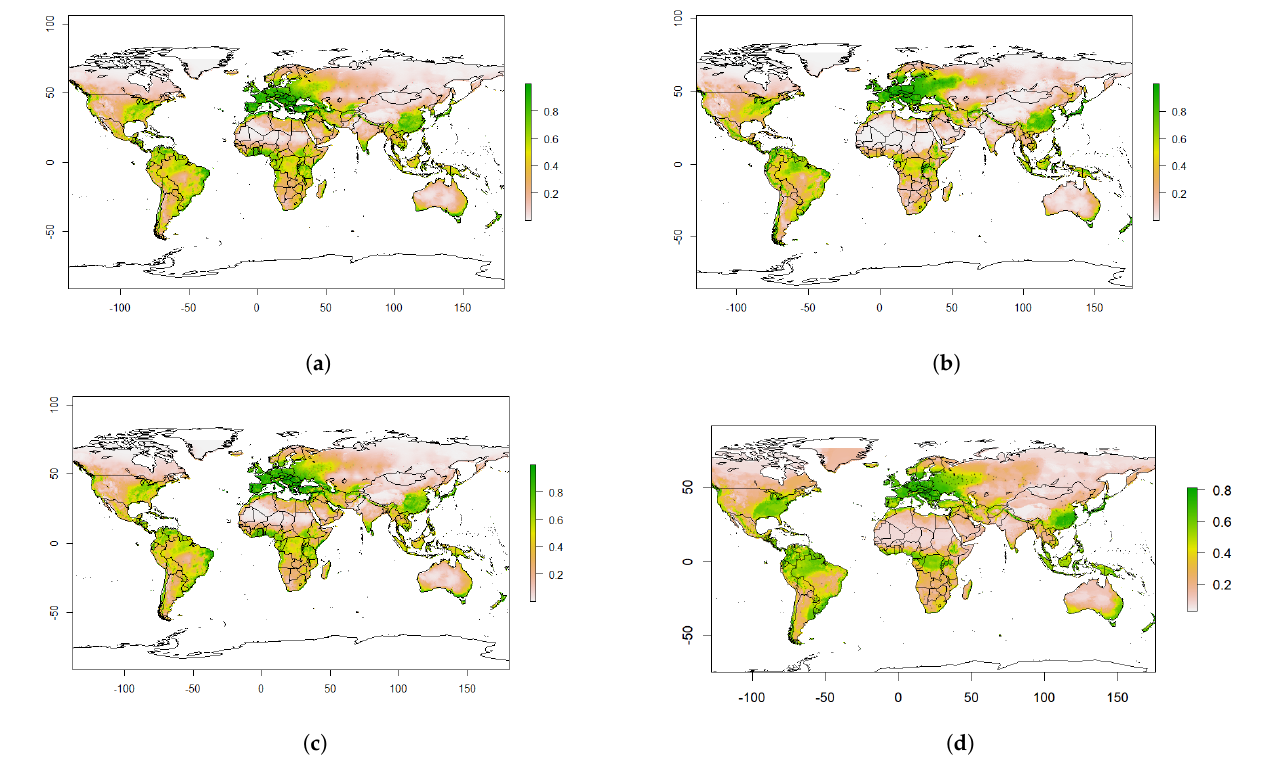
Figure 2. Prediction of habitat suitability distribution for ( a , b ) BTD and IBR, respectively, using ME. ( c , d ) BTD and IBR, respectively, using BRT. The greenish colour in the scale colour bar indicates suitable habitats for BRD occurrence, while the pinkish colour indicates habitats that are less suitable for BRD occurrence.